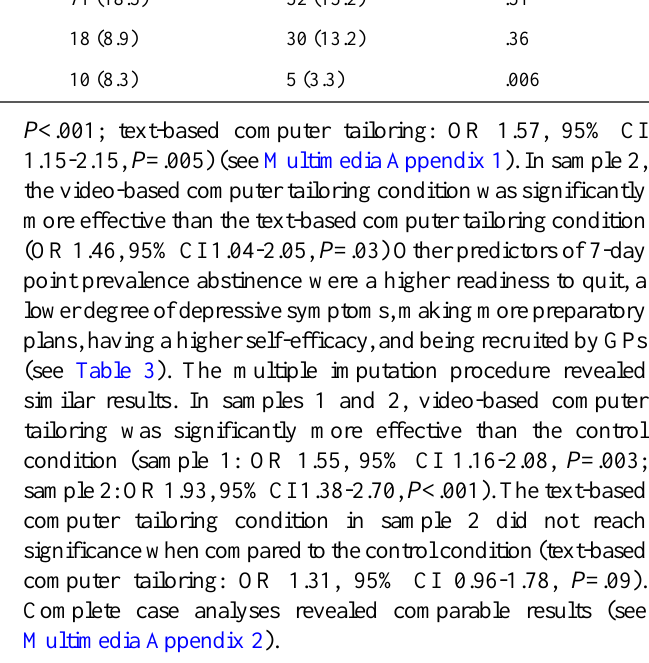
P valueCondition, n (%)Total, NNegative